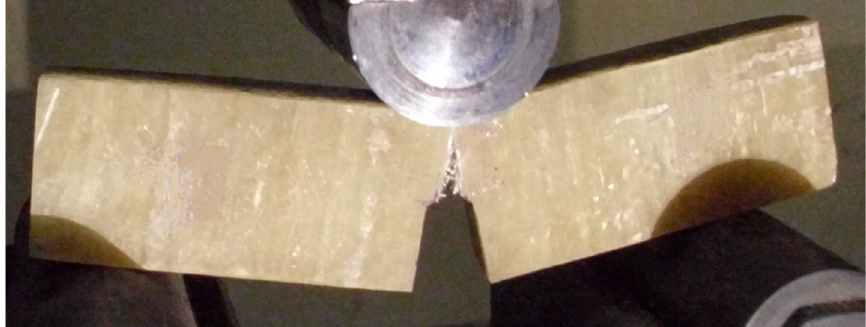
Figure 14. SENB’s fracture mode.